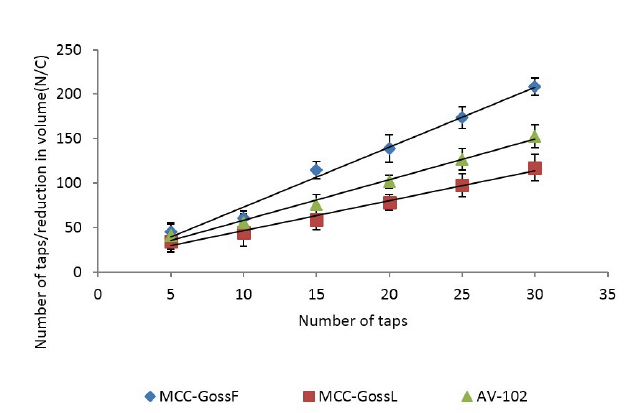
FIGURE 3 - Kawakita plots of MCC-GossF, MCC-GossL and AV-102.